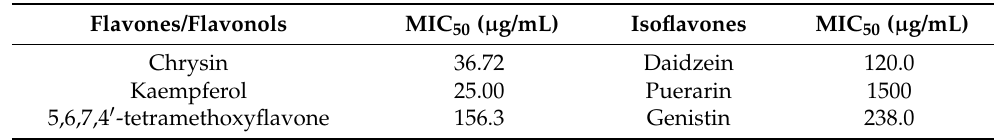
Table 4. Antibacterial activity of several flavones and isoflavones against E. coli via membrane interaction